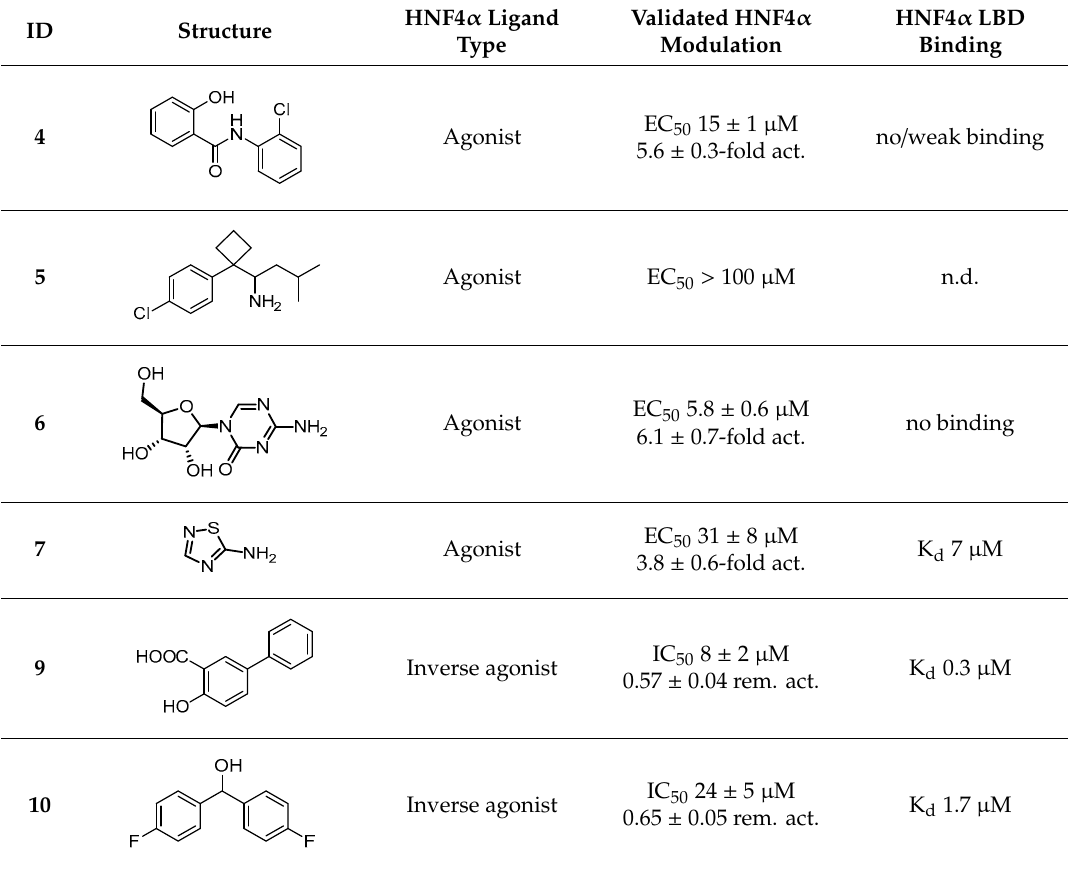
Table 2. Validated HNF4 α ligands with control experiment HNF4 α modulatory activity and binding a ffi nity to the recombinant HNF4 α ligand-binding domain (LBD). EC 50 and IC 50 values were calculated from dose–response curves and are the mean ± SD of at least four biologically independent repeats in duplicates. Fold and remaining (rem.) activation (act.) refer to the maximum fold increase or decrease in reporter activity relative to 0.1% DMSO. Binding was determined by isothermal titration calorimetry (ITC). n.d.—not determined